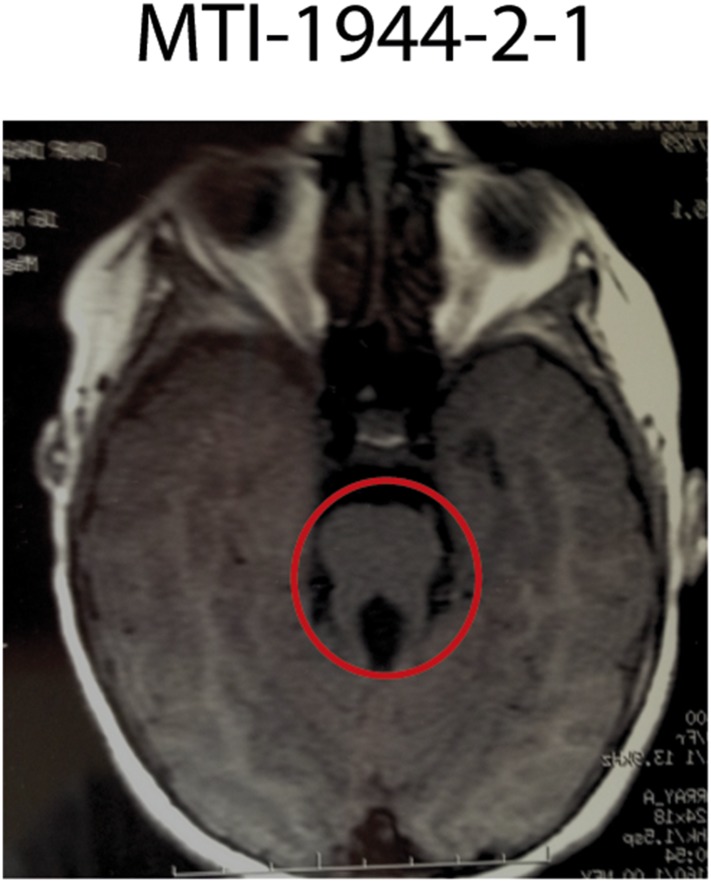
Imaging phenotype of affected JS individual MTI-1944-2-1 with KIAA0586 mutations.MRI of individual MTI-1944 affected by KIAA0586 mutations causing JS. For the affected individuals, the diagnosis of JS was confirmed by the deepened interpeduncular fossa and abnormal superior cerebellar peduncles, showing the ‘molar tooth sign’ (red circle).